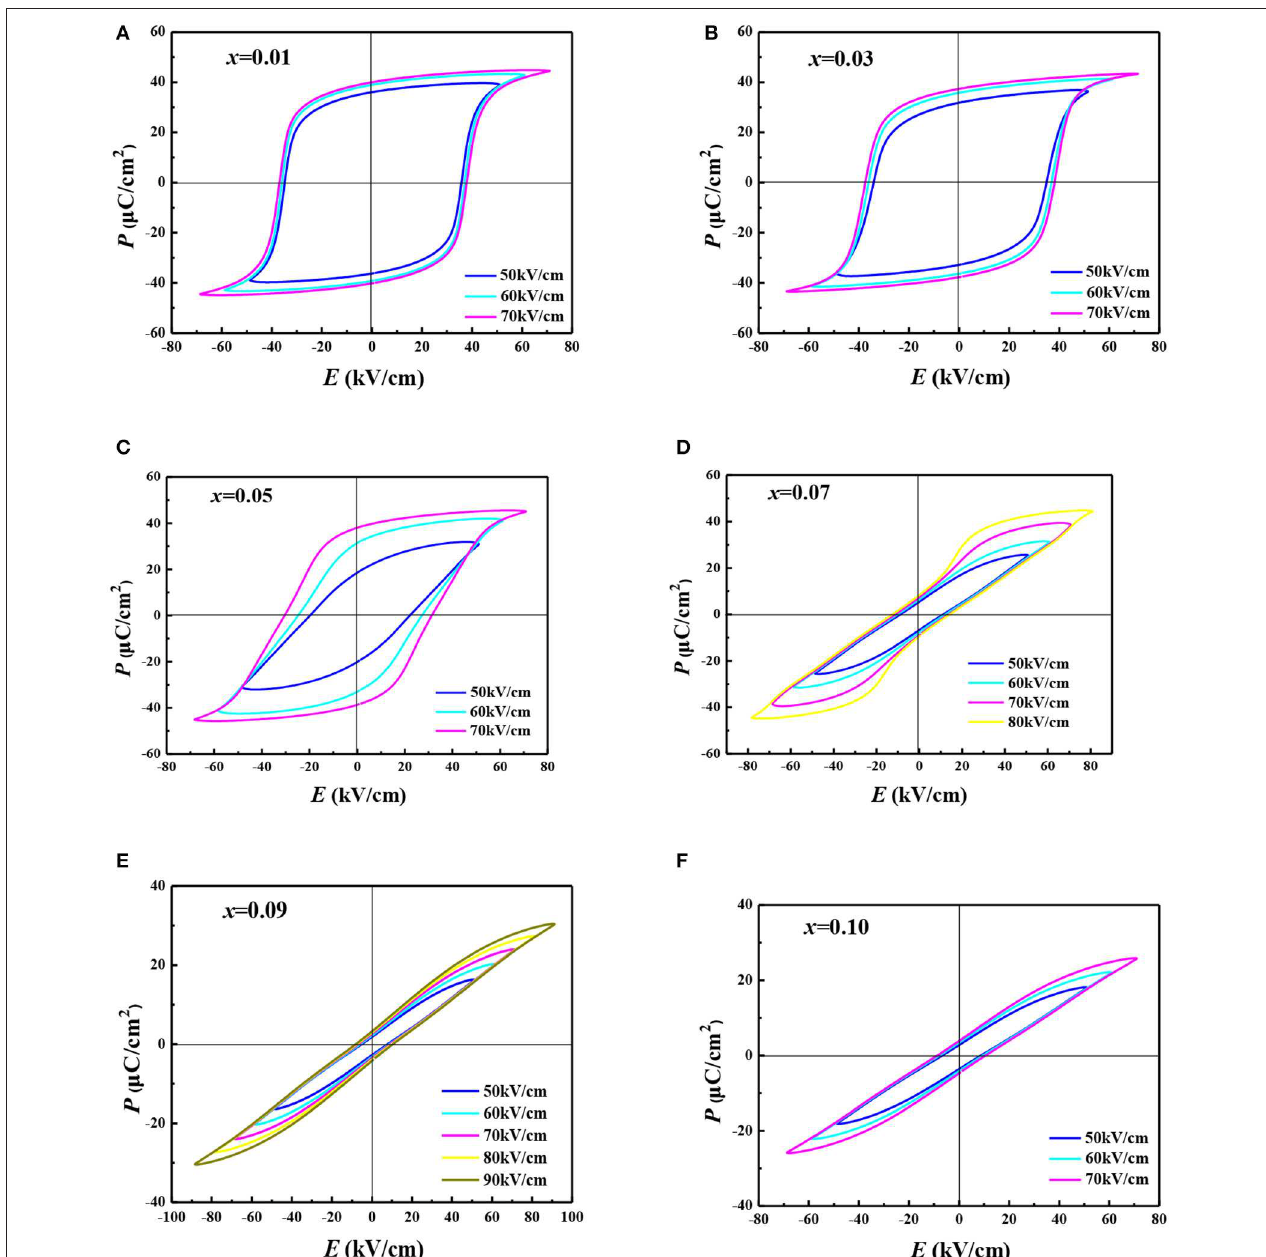
FIGURE 3 | P - E loops of BNKT- x FSN ceramics under different external electric fields with different FSN contents: (A) 0.01, (B) 0.03, (C) 0.05, (D) 0.07, (E) 0.09, (F) 0.10.